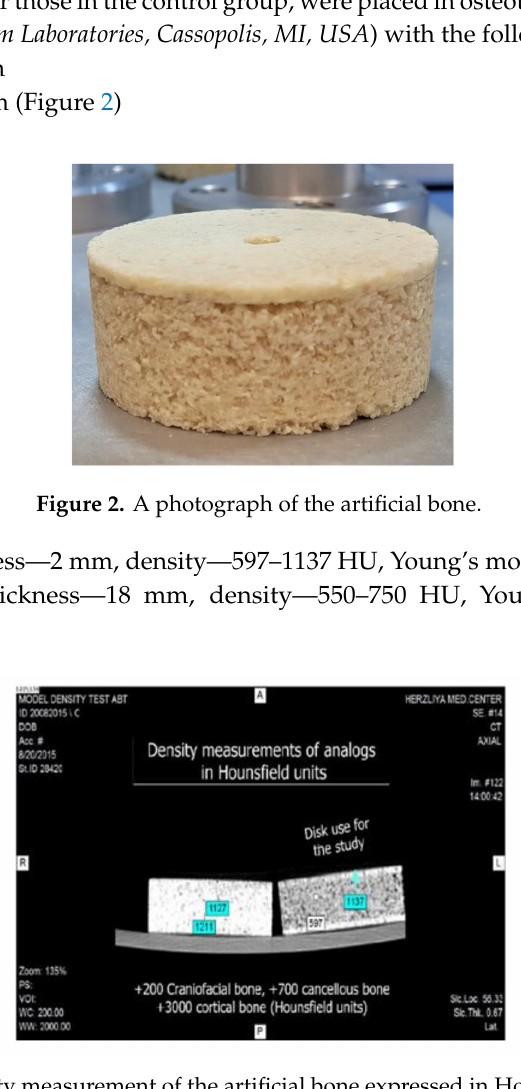
Figure 3. -Ray density measurement of the artificial bone expressed in Hounsfield units